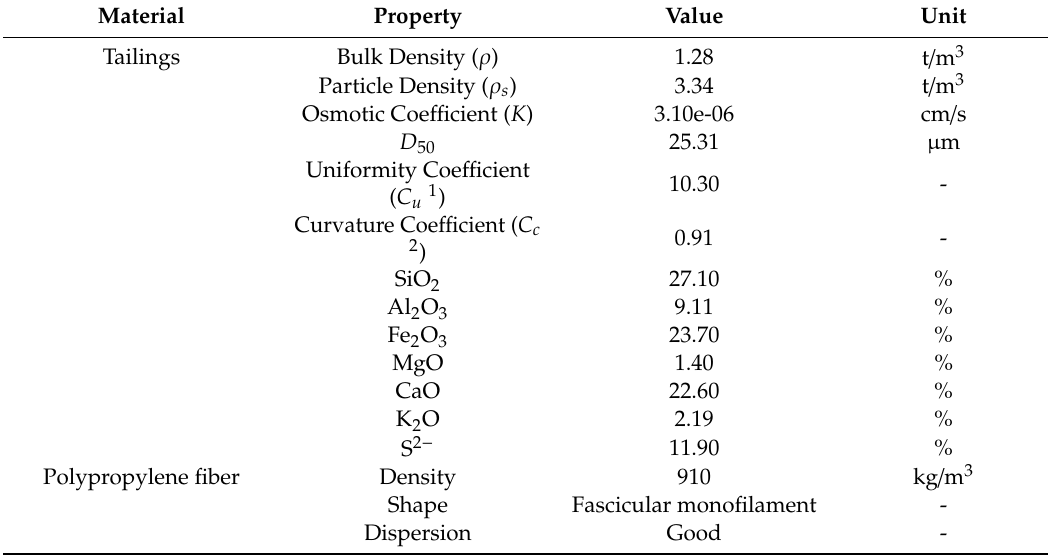
Table 1. Main properties of tailings and polypropylene